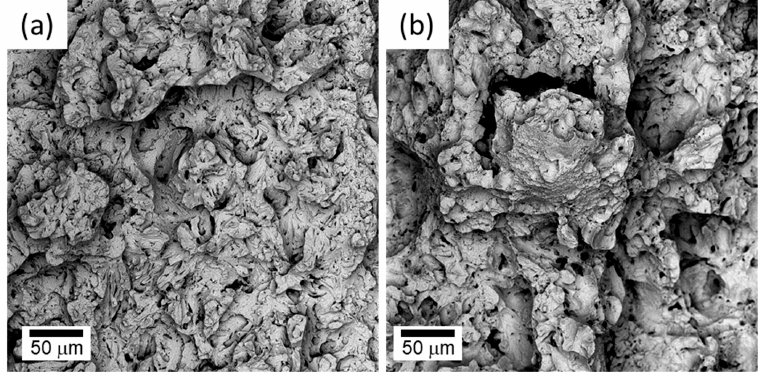
Figure 10. Charpy V-Notch fracture surfaces of the processed alloy tested at − 40 °C ( a ) N L Q L , ( b ) N L Q H .